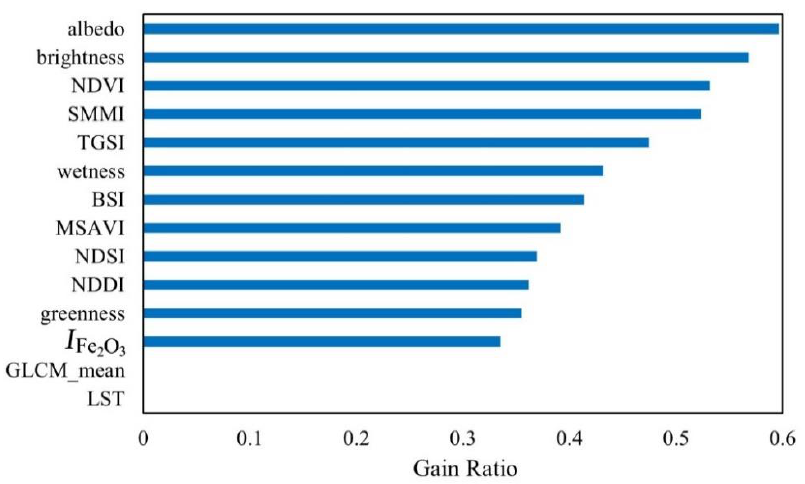
Figure A2. Selection results of the gain ratio. Gain ratio is the ratio of information gain to the intrinsic information, which is used in the C4.5 algorithm for feature selection.